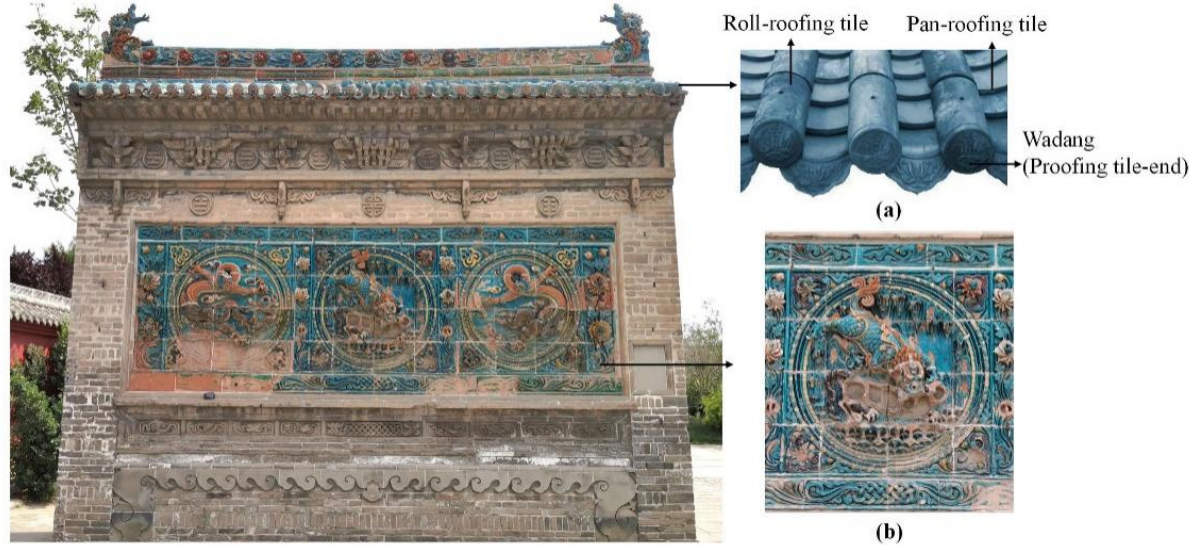
Figure 1. Glazed tiles decorated in different positions of ancient Chinese architecture. (This picture is the South screen wall in the Hancheng Confucian Temple) ( a ) Glazed tiles decorated on the roof. ( b ) Glazed tiles decorated on a screen wall.